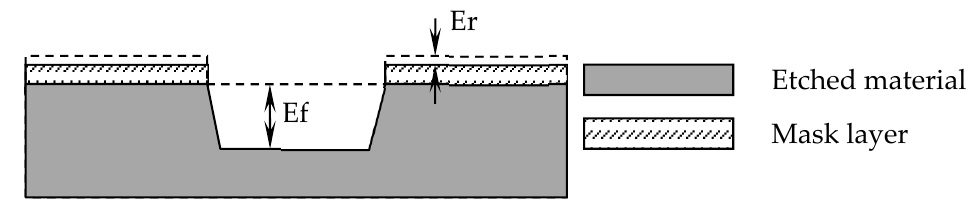
Figure 1. Etching selection ratio.